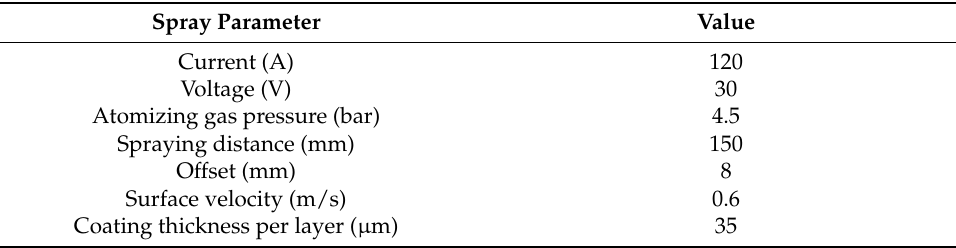
Table 1. Arc spray parameters for 17Cr steel